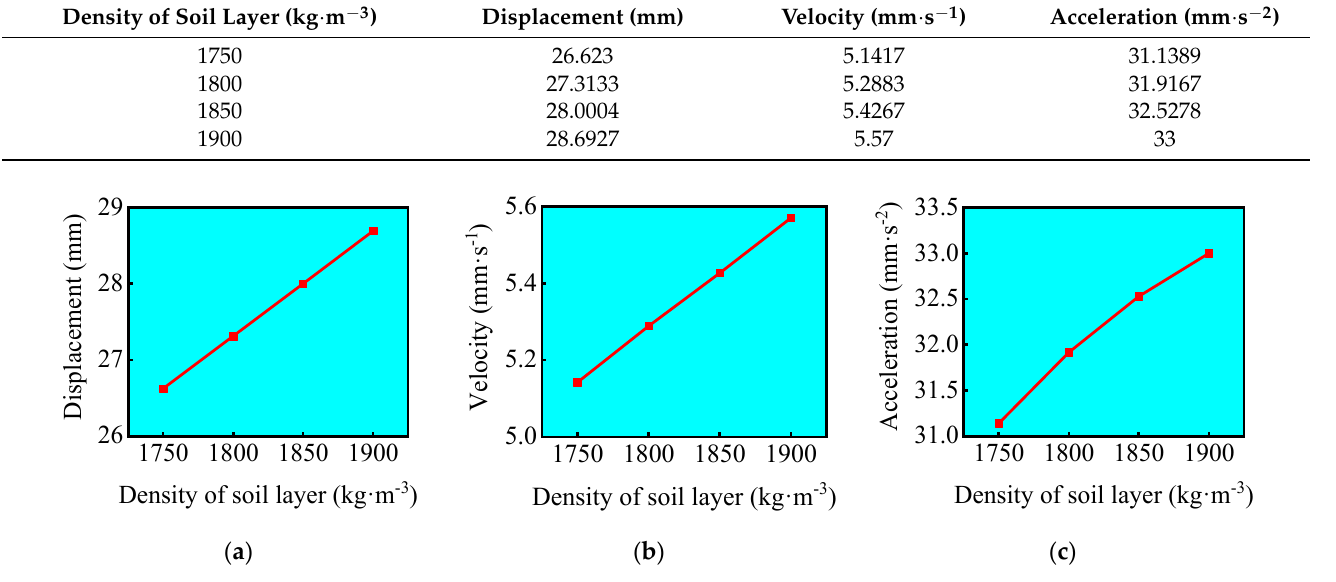
Figure 20. The law of mid − span peak value changing with density of soil layer ( a ) displacement, ( b ) velocity, and ( c ) acceleration.